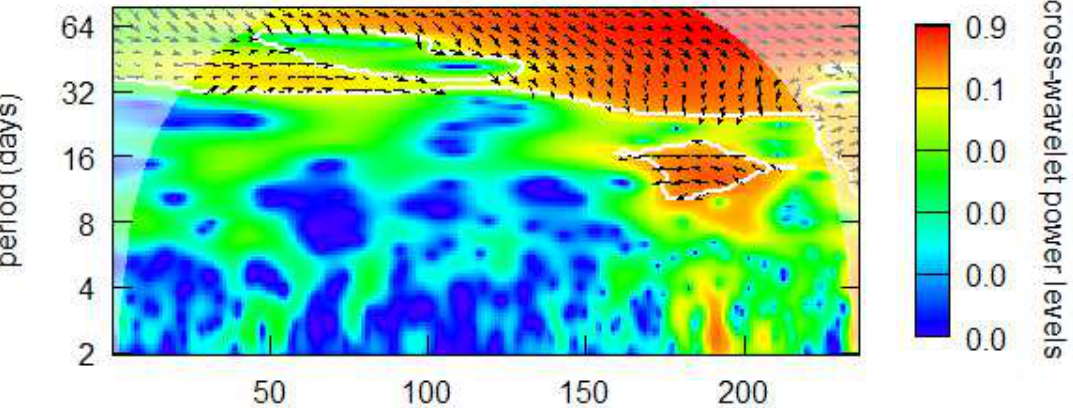
Figure 9. NASDAQ and Tokyo Stock Exchange